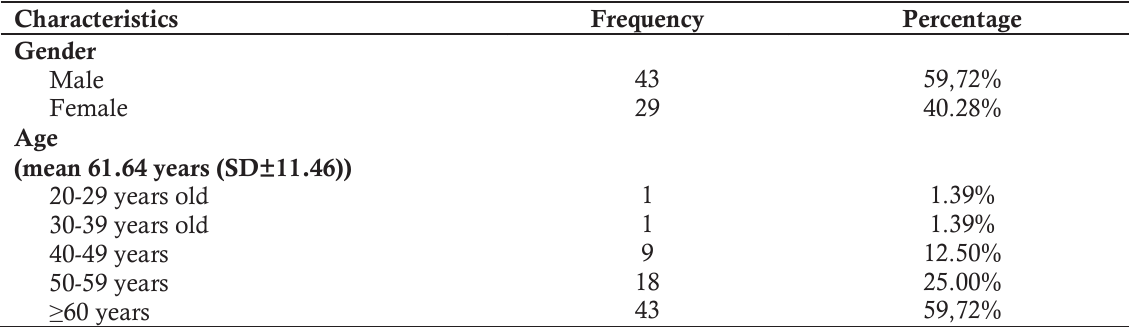
Table 3. Characteristics of demographic data of research subjects Table . Characteristics of demographic data of research Characteristics